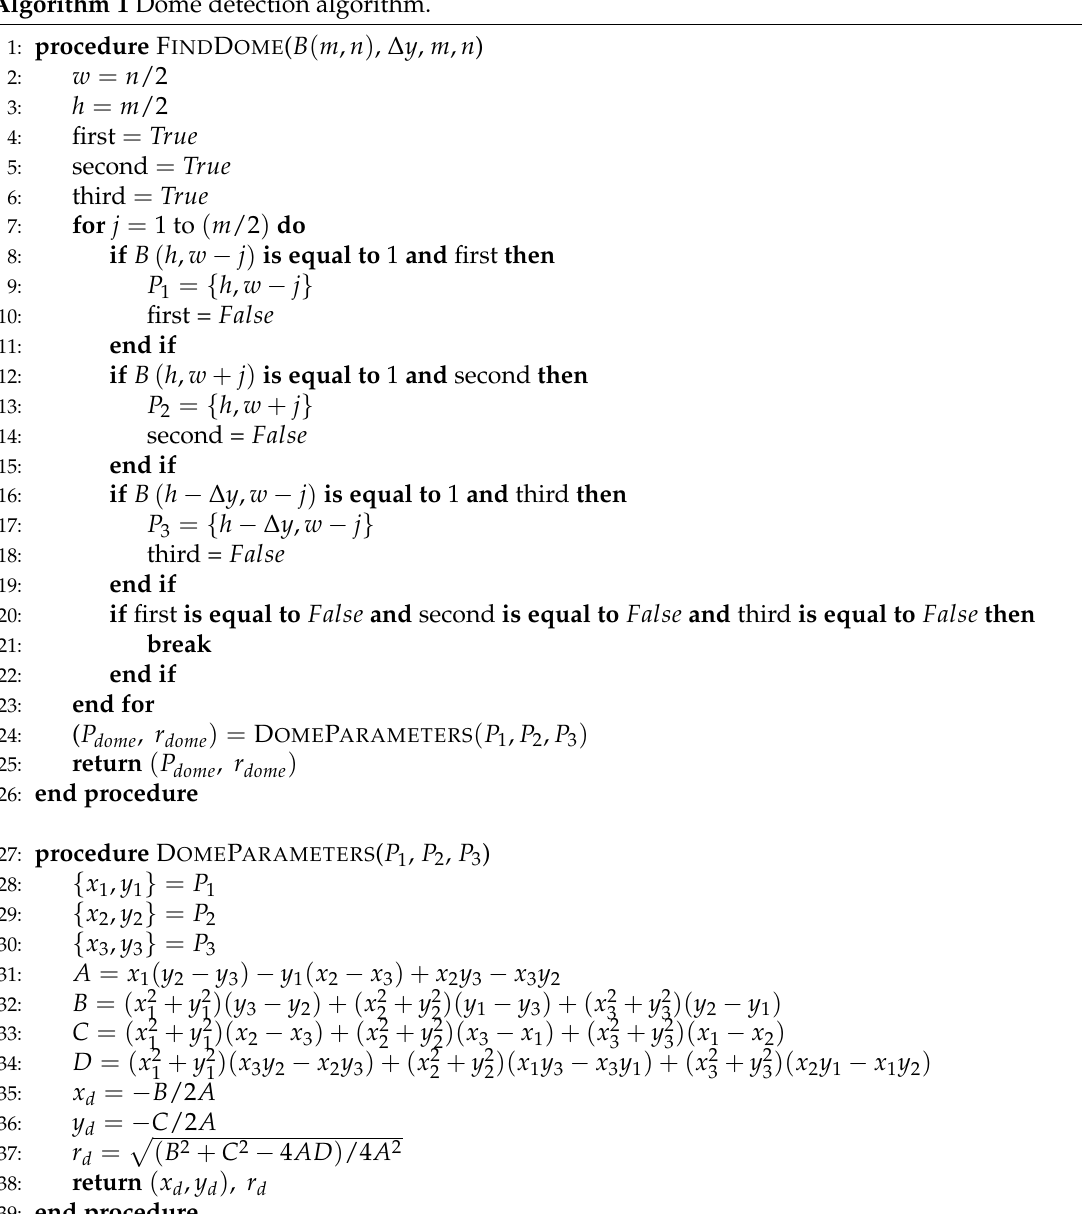
Algorithm 1 Dome detection